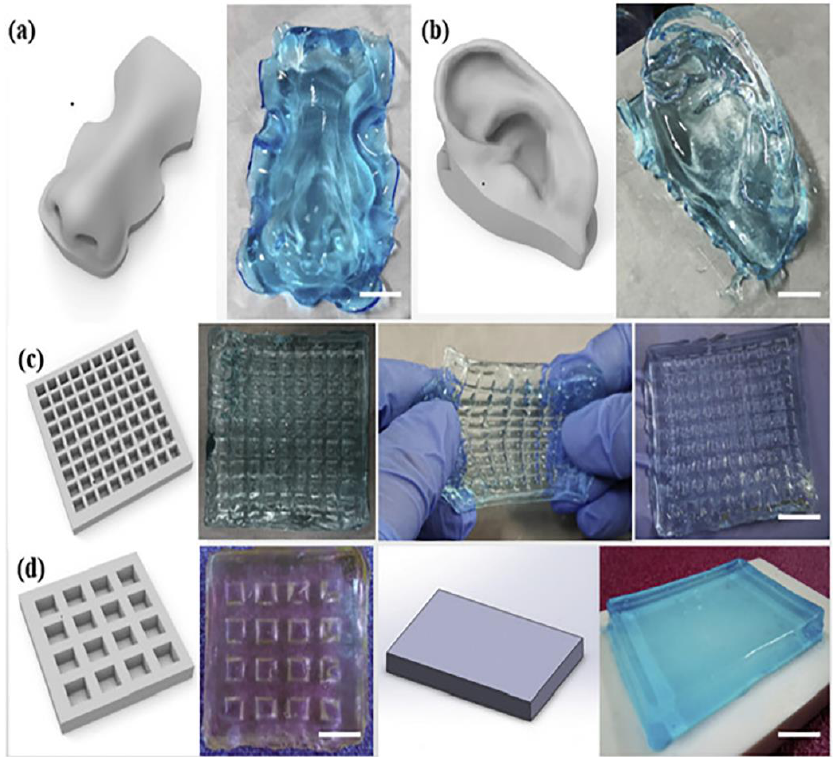
Figure 18. ( a ) DLP based 3D printing of CHIMA/PAM bioinks. ( b ) the CAD model and the printed construct of the nose. ( c ) the CAD model and the printed construct of the ear auricle with the helical fold. ( d ) Lattice structures of CHIMA/PAM hydrogels with different mesh size produced by DLP. Printed constructs were not damaged when they were stretched. Bar: 10 mm. Reprinted from [54], Copyright 2021, Elsevier.